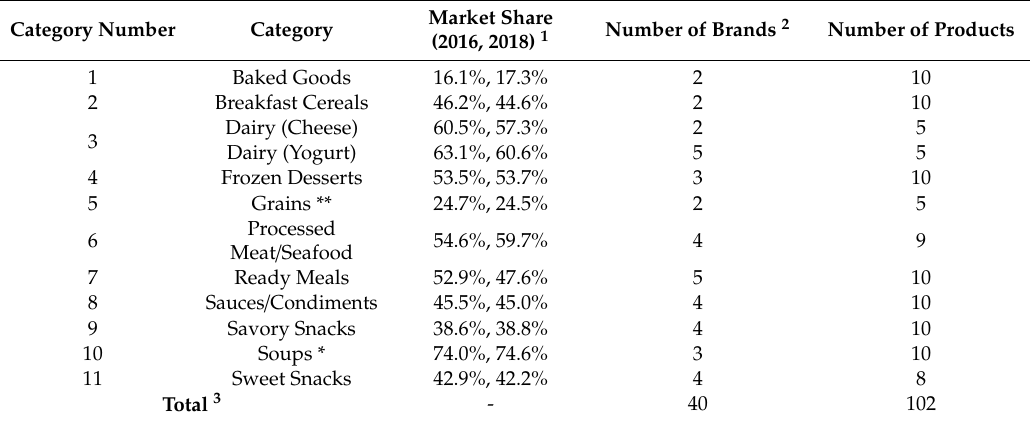
Table A2. Market Share Represented by Food Category